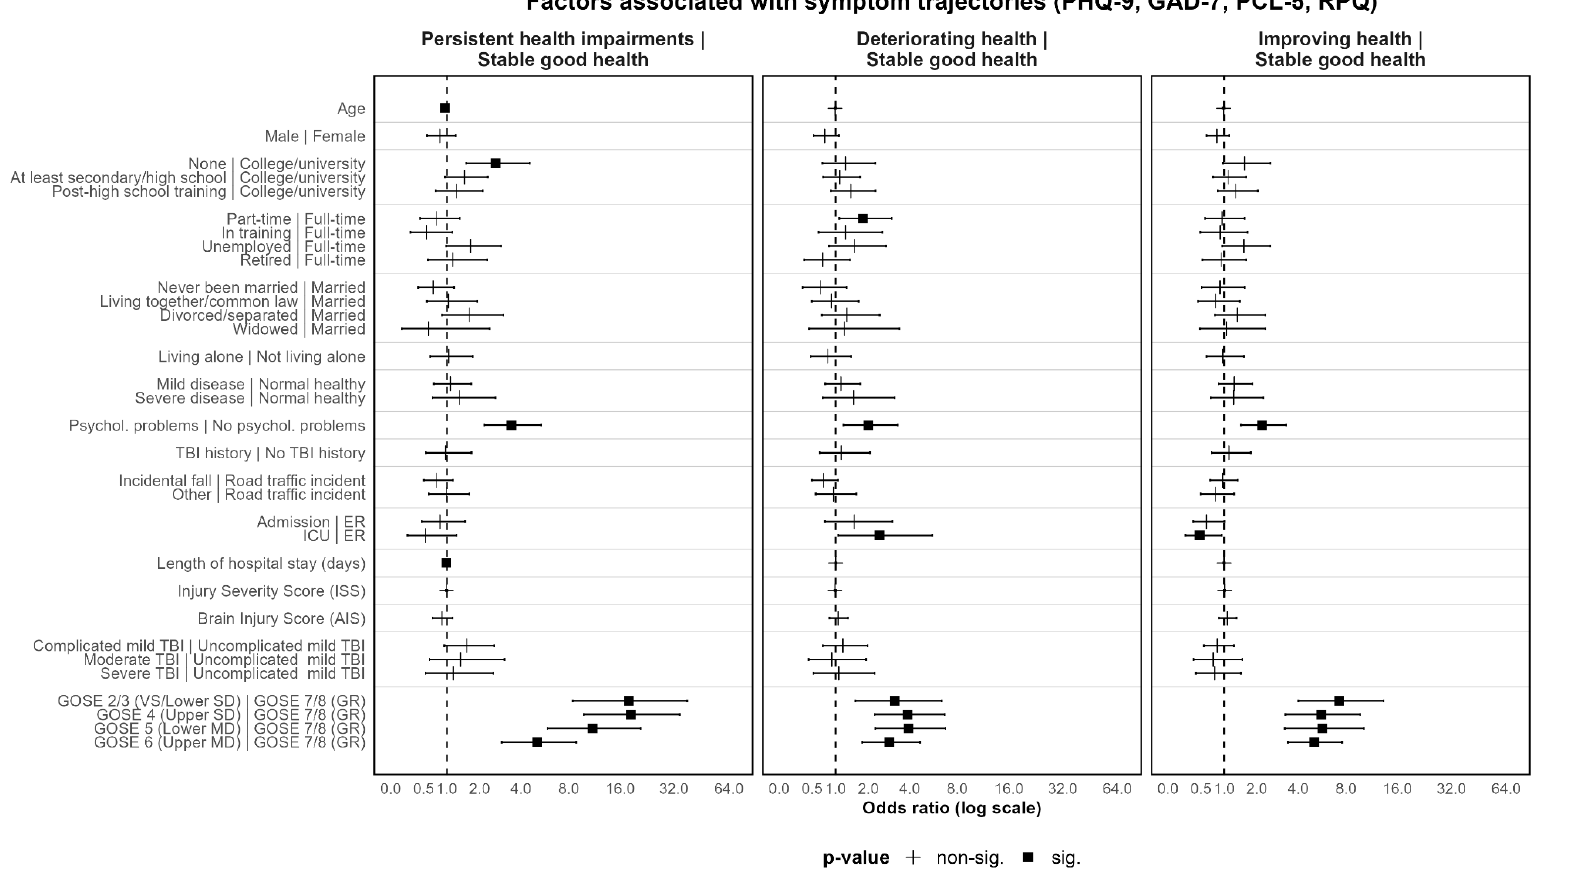
Figure 7. Symptom trajectories (PHQ-9, GAD-7, PCL-5, RPQ) for the four-class solution of model 1 (random intercept, fixed slope). Low stable health status class is used as the reference group. Odds ratios and 95%-confidence intervals depicted. Reference group for each categorical variable listed after vertical line. SD = severe disability, MD = moderate disability, GR = good recovery, ISS = Injury Severity Score, AIS = Brain Injury Score. Values below 1 indicate lower probability of belonging to the non-reference group (i.e., persistent health impairment, deteriorating health status, or improving health status) compared to the stable good health status group.